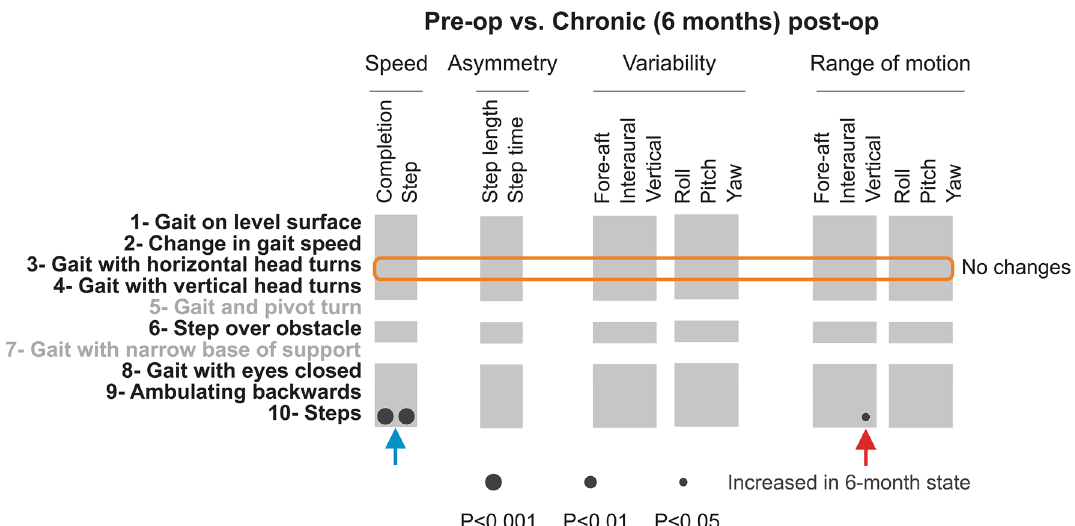
Figure 6. Comparison of objective head movement kinematics of pre-op and chronic post-op. Each column corresponds to a kinematic measure, while rows indicated FGA tasks. Dark circles show increased measure > 6 months after the surgery. The radius of the circle indicates the level of significance of the difference between the two groups. Orange box indicates the FGA task in which patients altered their kinematics the most from pre-op and chronic post-op patients. Blue and red arrows indicate specific kinematic measures, which were significantly changed from pre-op to chronic post-op states during the “steps”